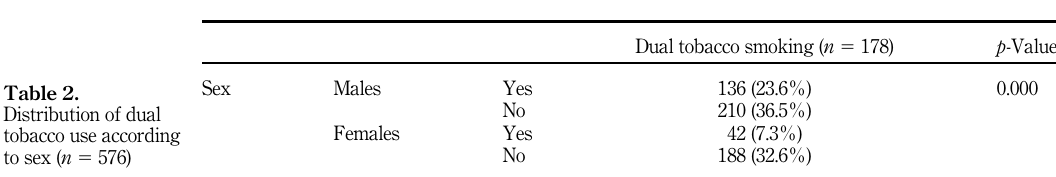
Table 1. Demographic characteristics and smoking habits of youth ( N 5 576)